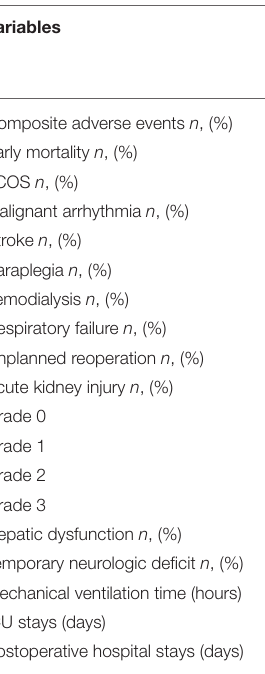
TABLE 3 | Early clinical